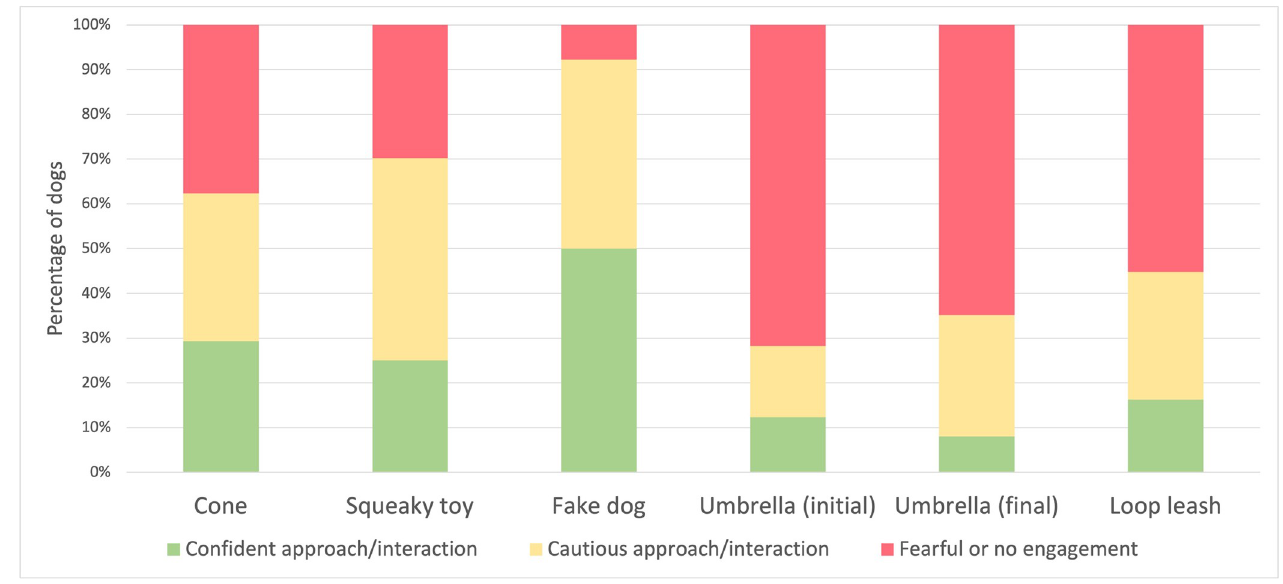
Fig 2. Dogs’ responses to non-social stimuli. Percentage of tested dogs (total n = 584) approaching or interacting with the stimulus in a confident manner (green), approaching or interacting with the stimulus in a cautious manner (yellow) or not engaging with the stimulus or showing a fearful response (red) when exposed to different stimuli such as a plastic traffic cone, a squeaky dog toy, a fake dog, an opening umbrella, or a loop leash placed around the